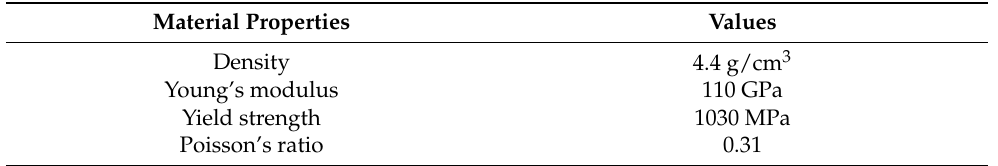
Table 3. Material properties of Ti-6Al-4V used for this study. Reprinted with permission from ref. [47,48]. Copyright 2022 Elsevier.